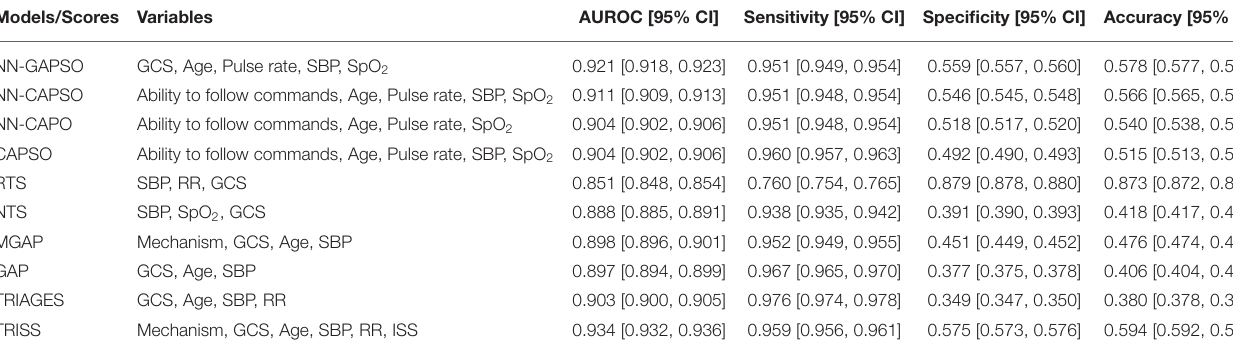
TABLE 3 | Comparison of the diagnostic properties of the models/scores at a sensitivity threshold of nearest 95%. Models/Scores Variables